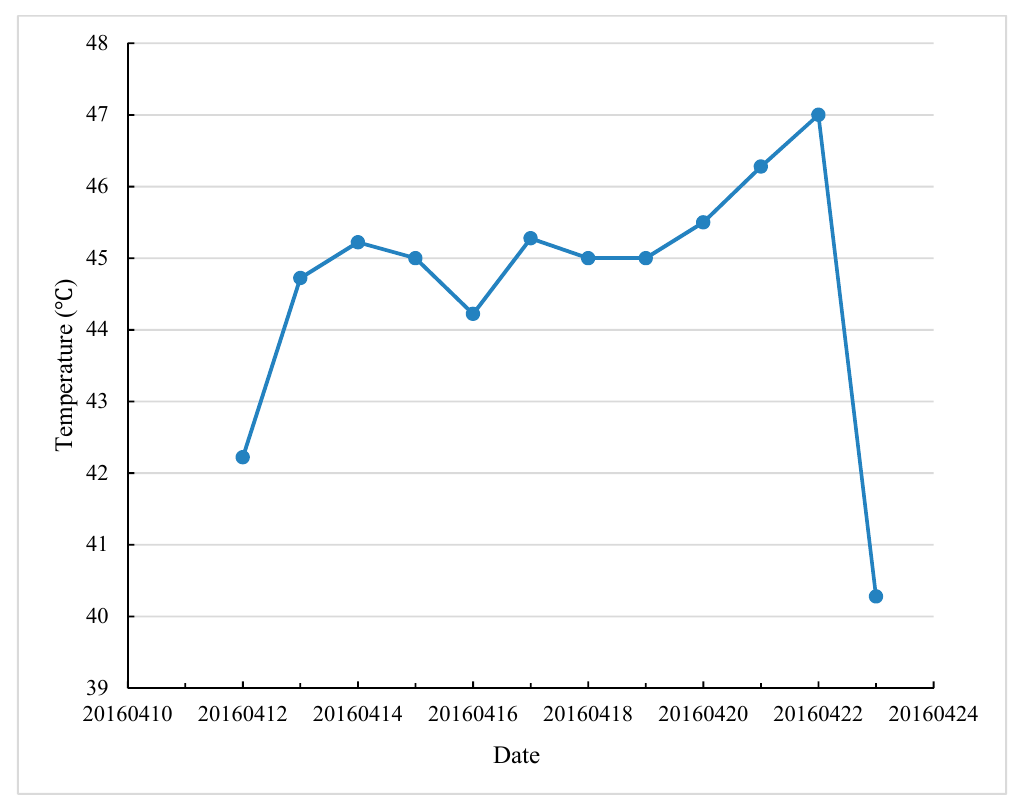
Figure 2. Average maximum temperature for 7 consecutive days over 30 years in certain African region (Data are from the reference [13]).